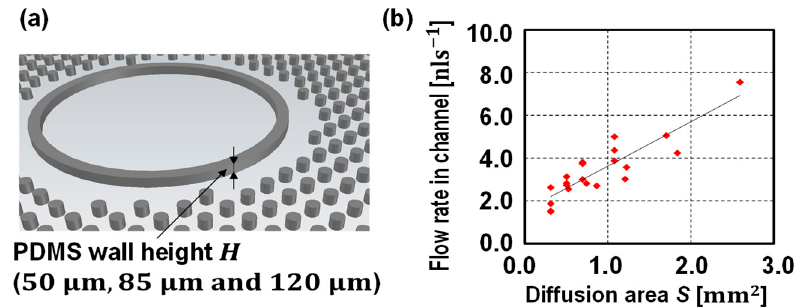
Figure 5. ( a ) One of the controlling diffusion area approaches and ( b ) flow rates against the diffusion area plot. The PDMS wall thickness was set at 100 µm, however, by adjusting the height of the PDMS wall (50 µm, 85 µm, and 120 µm), the diffusion areas were adjusted. Under these design conditions, the flow rates were proportional to the diffusion areas as described in Equation (1).